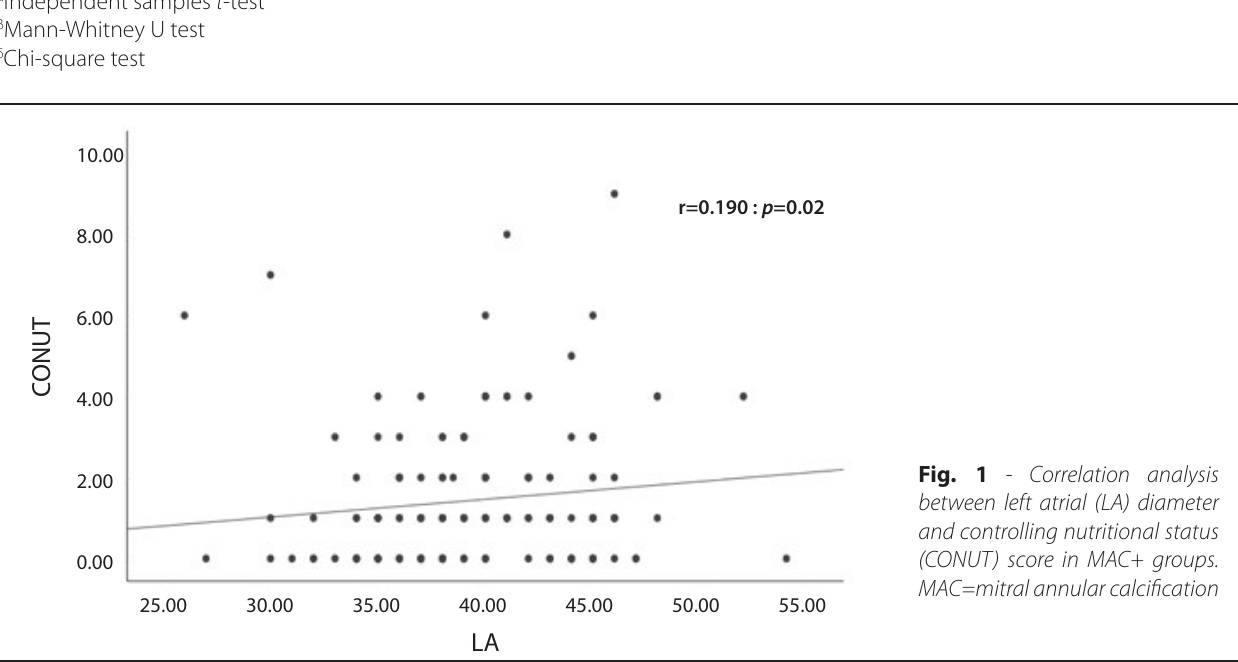
Fig. 1 - Correlation analysis between left atrial (LA) diameter and controlling nutritional status (CONUT) score in MAC+ groups. MAC=mitral annular calcification